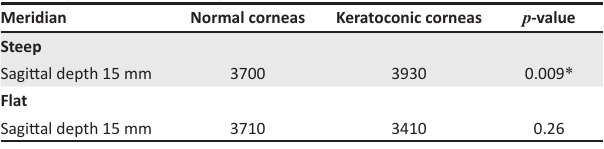
Meridian Normal corneas